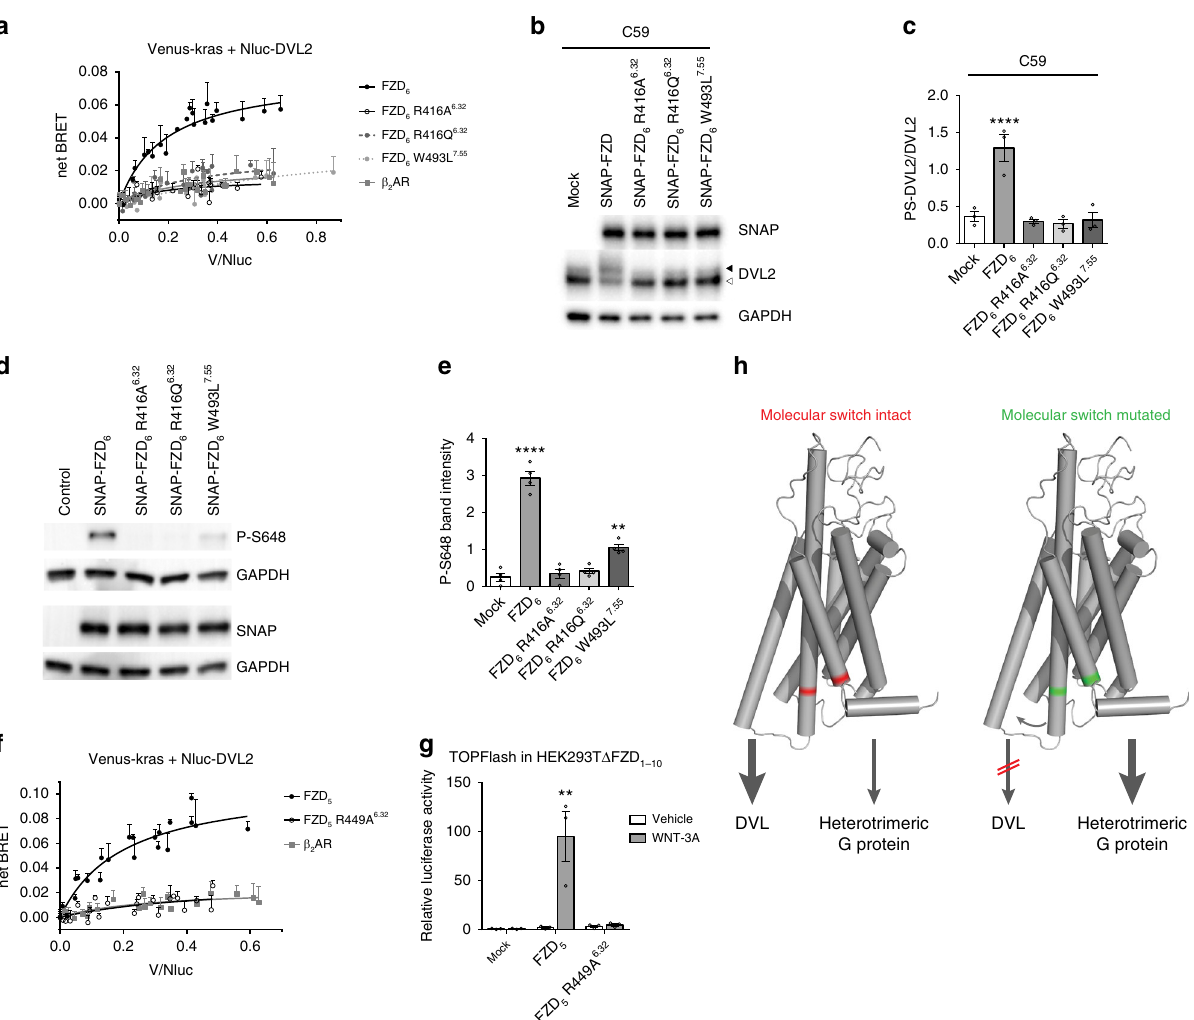
Fig. 4 Mutation of the molecular switch confers functional selectivity. a To quantify DVL2 membrane recruitment, bystander BRET between Venus-kras and Nluc-DVL2 was assessed over a range of acceptor/donor ratios in the presence of FZD 6 , FZD 6 R416A 6.32 , FZD 6 R416Q 6.32 , FZD 6 W493L 7.55 or the β 2 - adrenergic receptor as negative control. net BRET values are presented as mean ± standard deviation (s.d.) of n = 3 independent experiments. b , c HEK293 cells transfected with empty vector (control), FZD 6 , FZD 6 R416A 6.32 , FZD 6 R416Q 6.32 , or FZD 6 W493L 7.55 were analyzed by immunoblotting using anti- SNAP, -DVL2, and -GAPDH (loading control) antibodies. Bar graphs for the ratio of PS-DVL2 (upper band) to DVL2 (lower band) summarize densitometry data. Experiments were performed in the presence of 5 nM C59 (overnight). Data are presented as mean ± s.e.m. of n = 4 independent experiments; P = 0.0002, F (4, 10) = 17.71. *** P < 0.001 (one-way ANOVA). See also Supplementary Figure 7. d , e HEK293 cells cotransfected with empty vector, FZD 6 , FZD 6 R416A 6.32 , FZD 6 R416Q 6.32 , or FZD 6 W493L 7.55 and DVL2/CK1 ε were analyzed by immunoblotting using anti-phospho-S648 FZD 6 , anti-SNAP, and anti-GAPDH antibodies. The P-S648 signal was quanti fi ed by densitometry and summarized in a bar graph. Data are presented as mean ± s.e.m. of n = 3 independent experiments; F (4, 15) = 83.78., **** P < 0.0001, ** P < 0.01 (one-way ANOVA). f In a similar setup to a bystander BRET was measured between Venus-kras and Nluc-DVL2 in the presence of FZD 5 , FZD 5 R449A 6.32 or the β 2 -adrenergic receptor (data points for β 2 -adrenergic receptor are identical to a ). net BRET values are presented as mean ± s.d. of n = 3 independent experiments. g HEK293T Δ FZD 1-10 cells were transfected with Renilla and Fire fl y luciferase together with empty vector (control), FZD 5 , or FZD 5 R449A 6.32 and stimulated with 300 ng ml − 1 recombinant WNT-3A overnight. The luciferase signal was normalized to the average of unstimulated control values. Data are represented as mean ± s.e.m. of n = 3 independent experiments. P = 0.0065, F (2, 6) = 13.12. ** P < 0.01 (one-way ANOVA). h Schematic presentation of the concept of conformation-driven signaling bias of wild-type FZD and molecular switch mutant FZD. FZD models were produced in PyMOL (The PyMOL Molecular Graphics System, Version 2.0 Schrödinger, long-lived in the wild type than in the mutant receptors. These in silico observations support the concept of a molecular switch in receptor activation allowing association of an intracellular transducer — the heterotrimeric G protein.